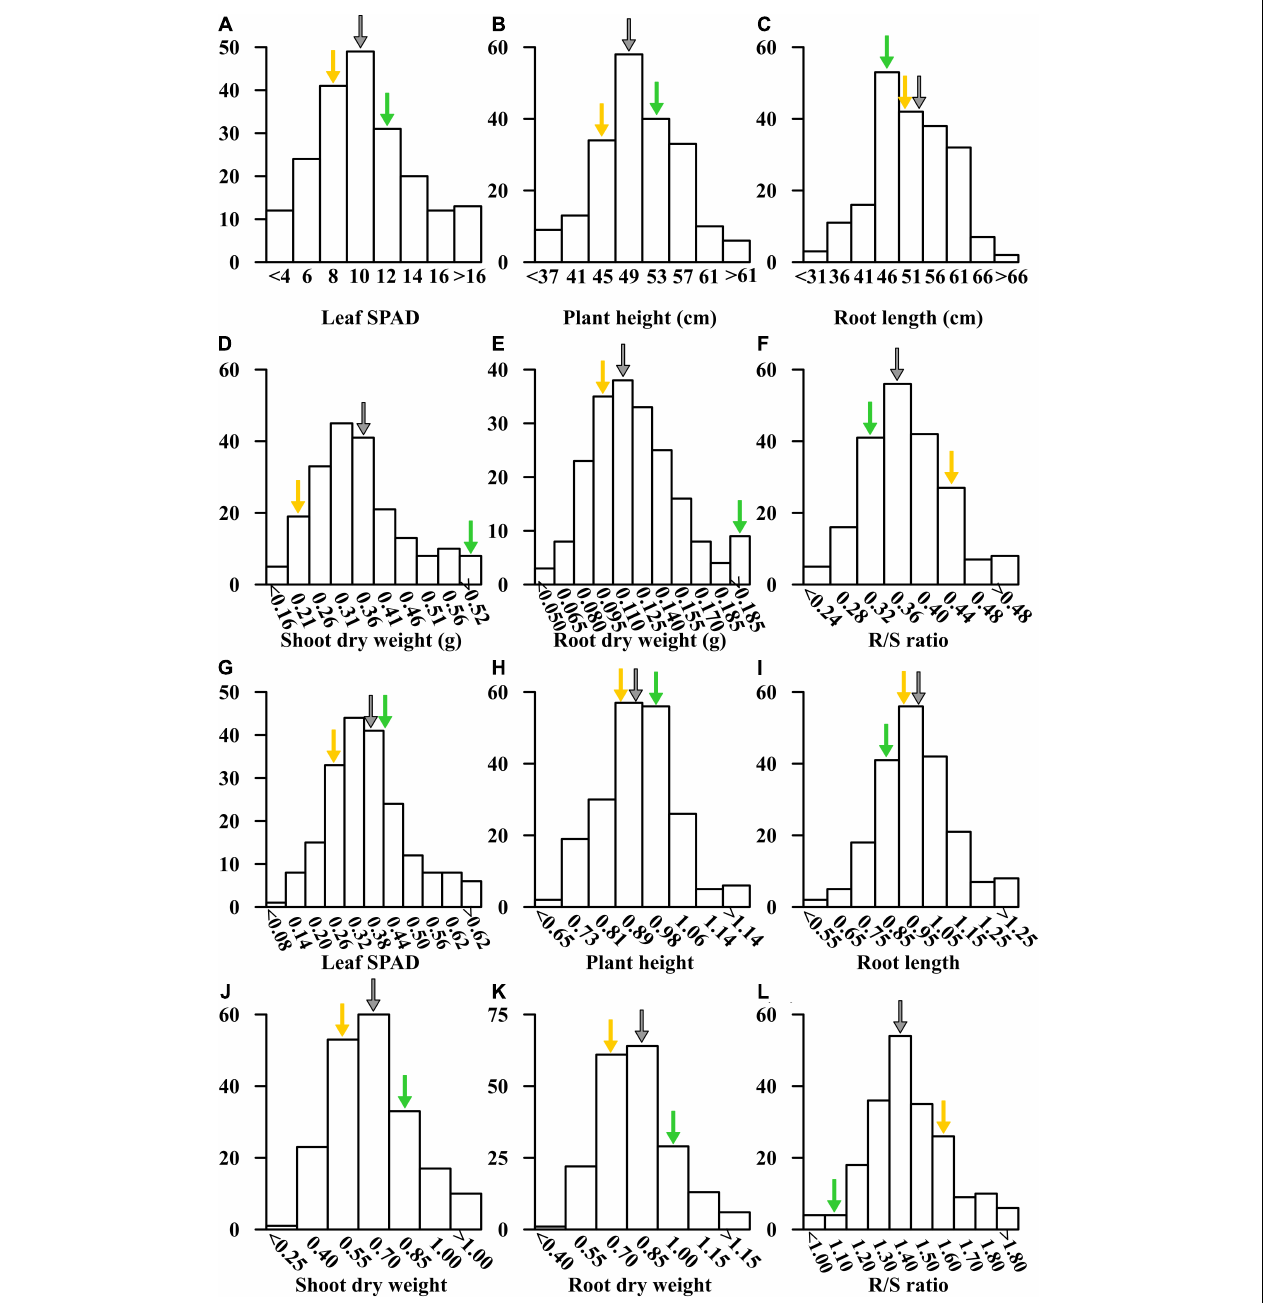
FIGURE 5 | Distribution of SPAD value of the fourth leaf (A,G) , plant height (B,H) , root length (C,I) , shoot (D,J) and root dry weights (E,K) , and R/S ratio (F,L) in the –Fe and –Fe/+Fe treatments are shown in (A–L) , respectively. Yellow and green arrows represent the mean values for each trait of Fe-inefficient parent Wu312 and Fe-efficient parent Ye478, respectively. Gray arrows indicate the mean values of each trait in the Ye478 × Wu312 RIL